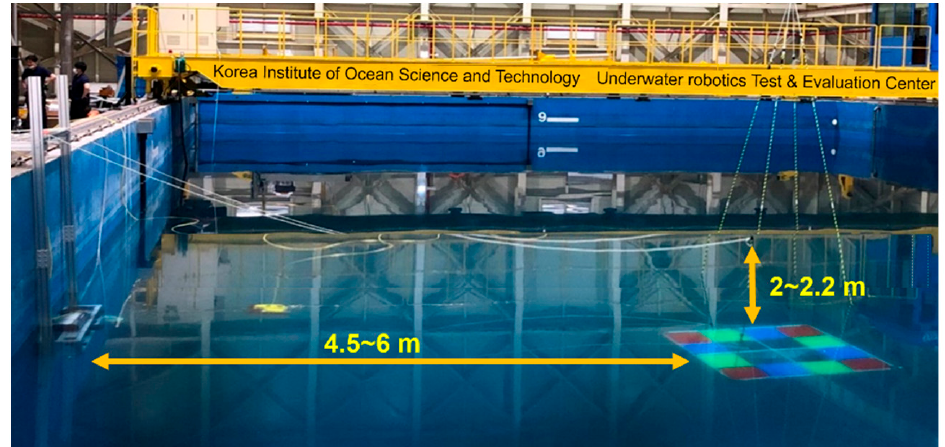
Figure 6. Experimental setup of the RGB phantom and optical-sonar fusion system for acquisition of calibration data. Table 3. Different setup locations of the RGB phantom for acquisition of geometric calibration data.